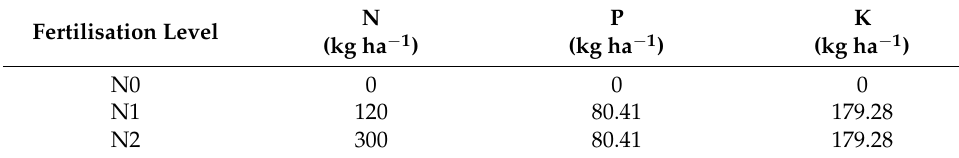
Table 3. NPK fertilisation doses applied in the long-term multifactorial experiment. Fertilisation